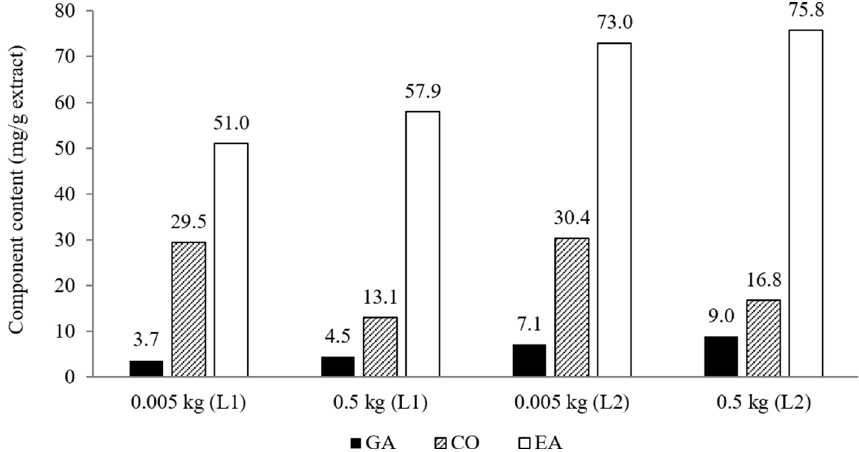
Figure 5. Total component content in laboratory-scale extract (0.005 kg sample) and scale-up extract (0.5 kg sample) for L1 and L2 operating condition. GA: gallic acid, CO: corilagin, EA: ellagic acid.